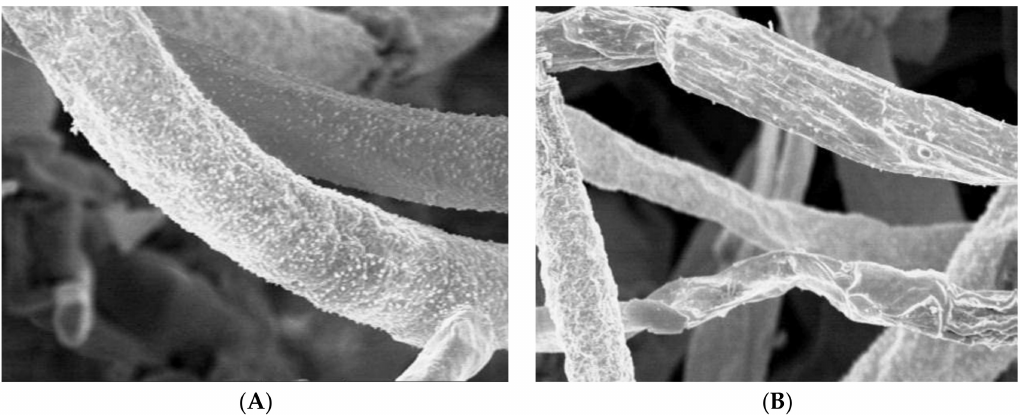
Figure 12. SEM micrographs of A. solani . ( A ). The untreated mycelia are well-developed inflated having normal wall. ( B ). The treated mycelia by AgNPs (100 µ g/mL) showing plasmolysis, distorted, squashed and collapsed hyphae and completely flat and empty dead hyphae. Scale bar = 5.0 µ m.